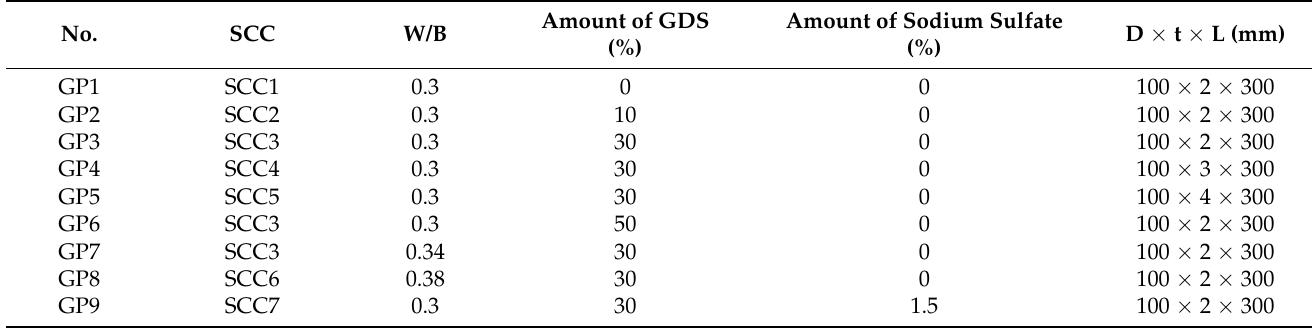
Table 3. Parameters of the CFST